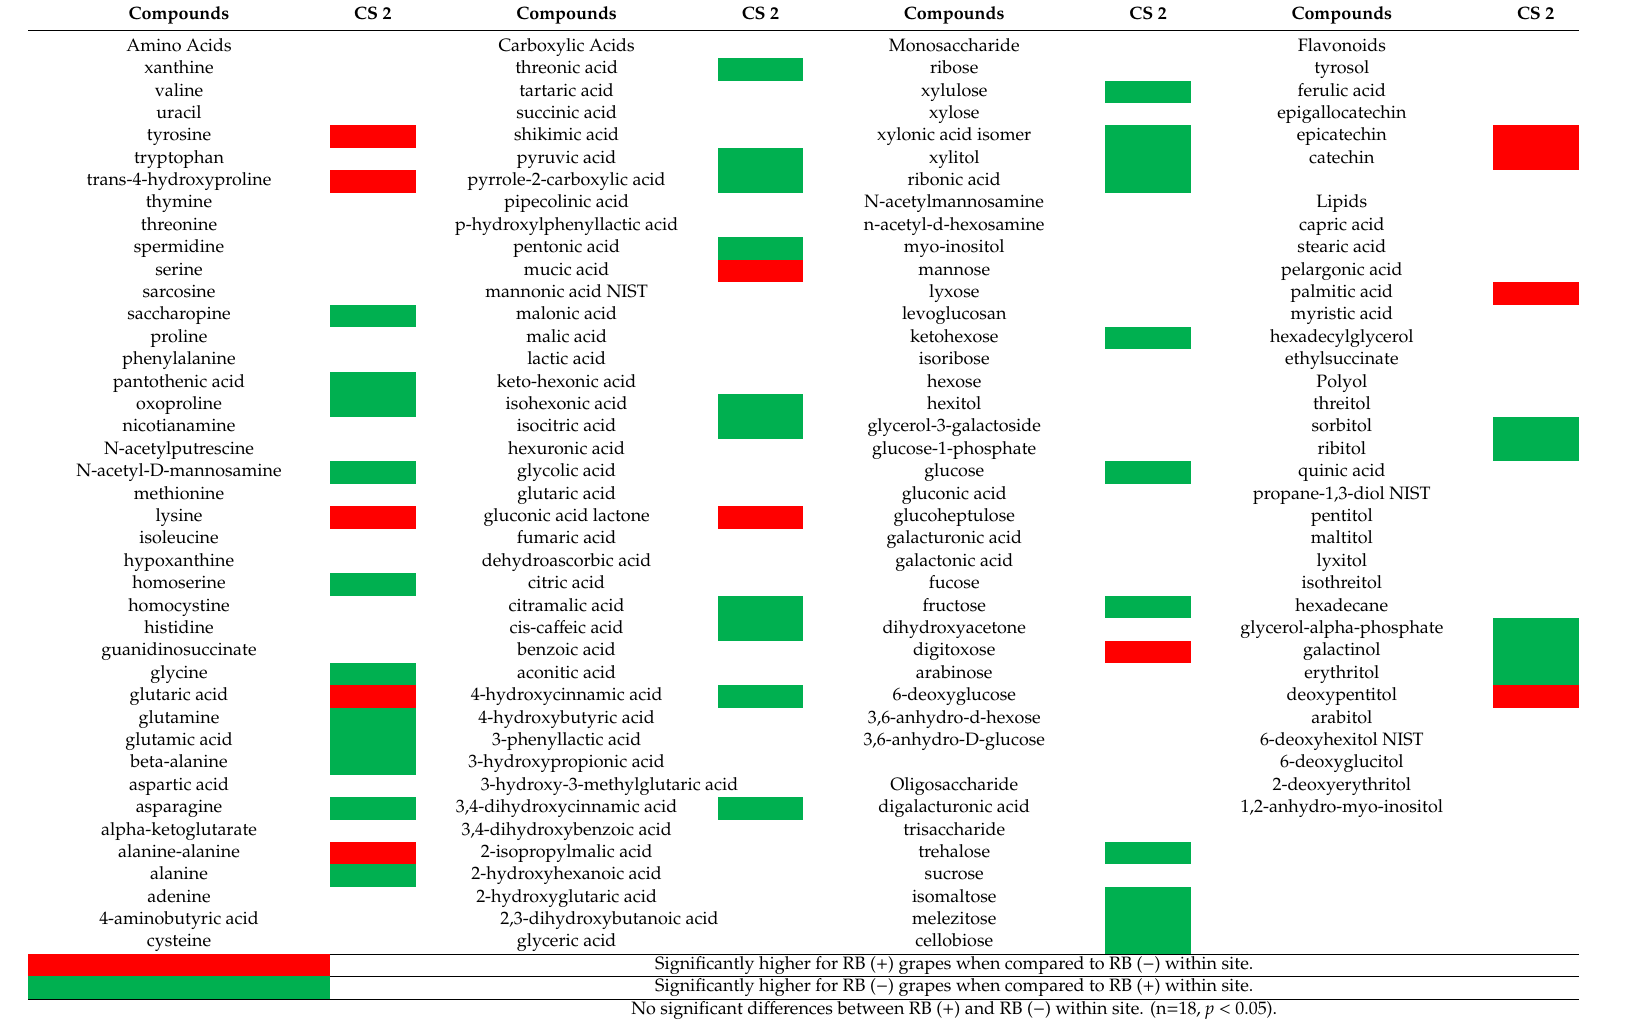
Table 6. Primary and secondary metabolites impacted by GRBD as determined by untargeted metabolomics for CS2 2015